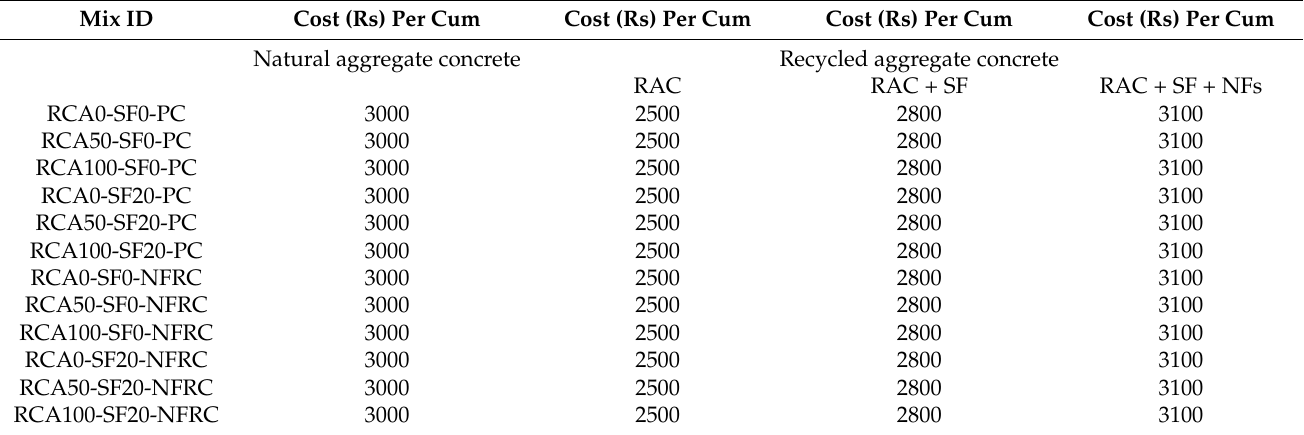
Table 9. Cost Benefit